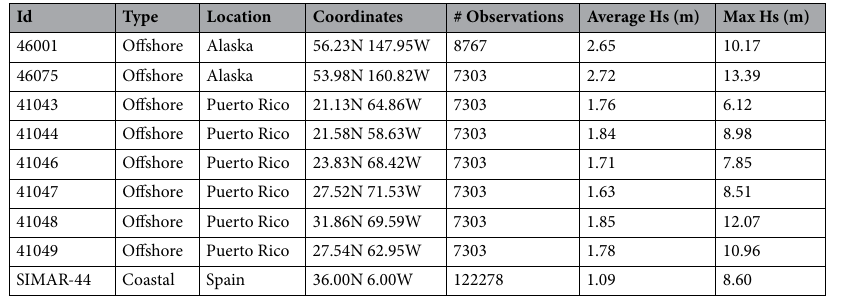
Table 1. Characteristics of the time series recorded for every